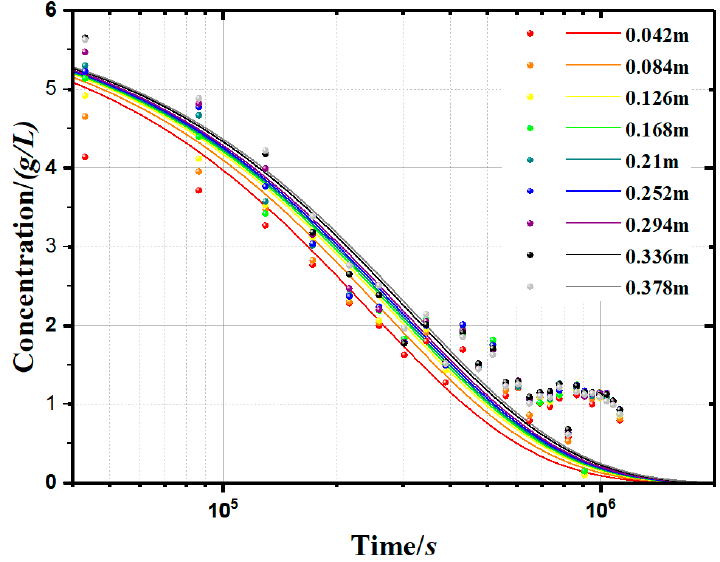
Figure 8. Measurement and modelling results of kaolinite suspension concentration (0.1g/L apple pectin experimental group).